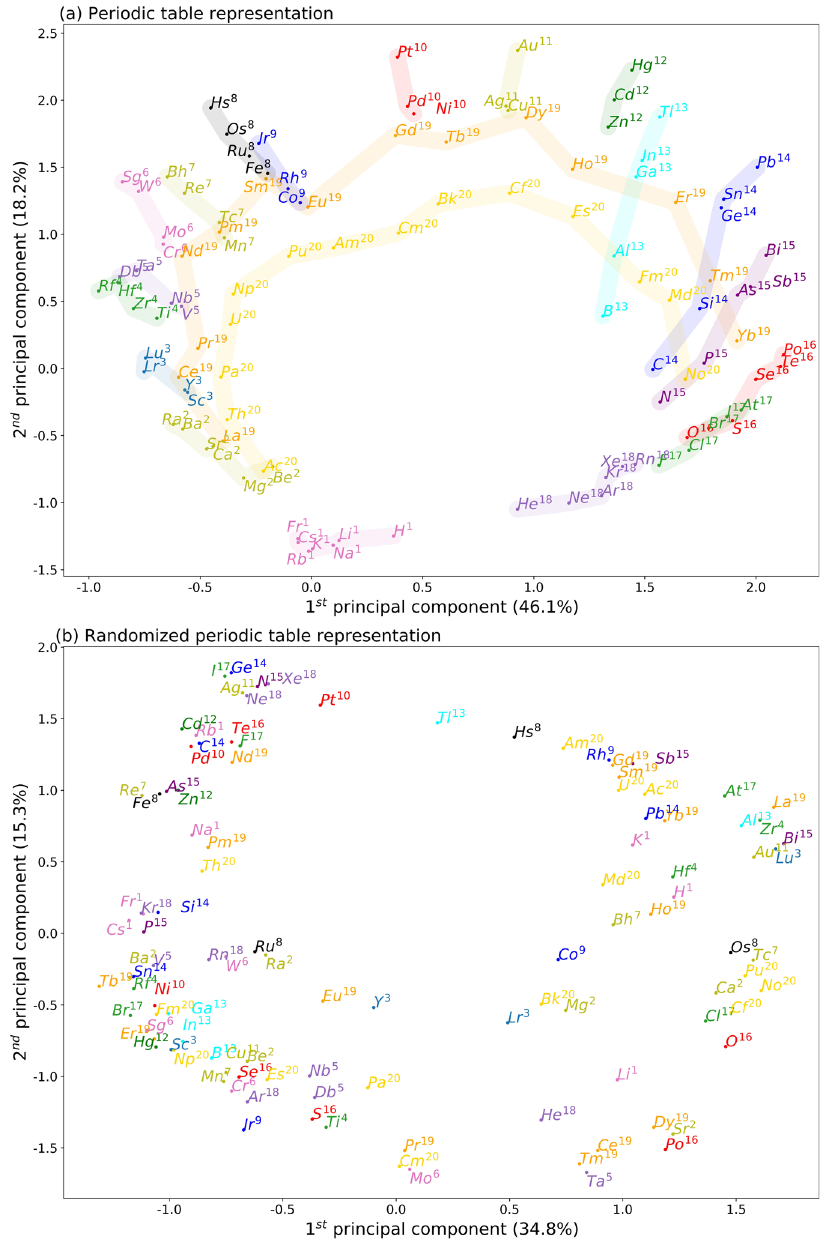
Fig. 6 Features analysis of the GFA prediction model after PCA. Projection of the feature vectors of 108 elements onto the plane spanned by the fi rst and second principal axes. The percentage represents the ratio of the variance on the principal axis direction. Elements are colored according to their elemental groups. a Periodic table representation. b Randomized periodic table representation. The superscript 1 – 18 on element symbol represents the element ’ s group number; superscript 19 and 20 represent lanthanide and actinides,